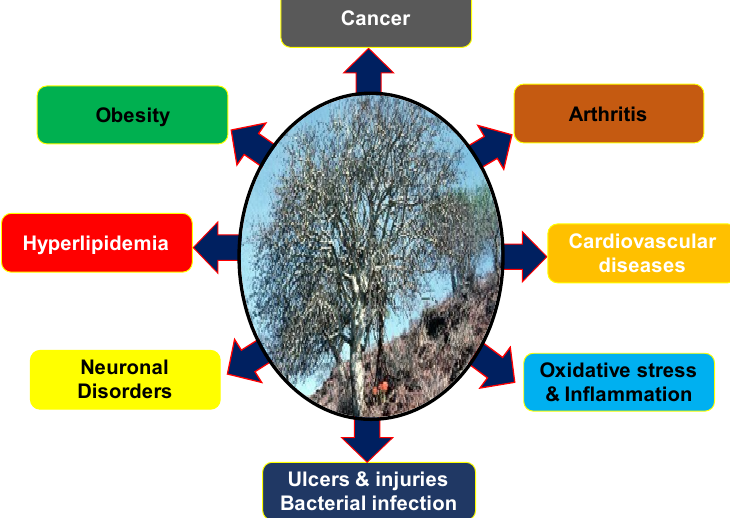
Figure 1. Biological activities of Commiphora wightii (Mark W.